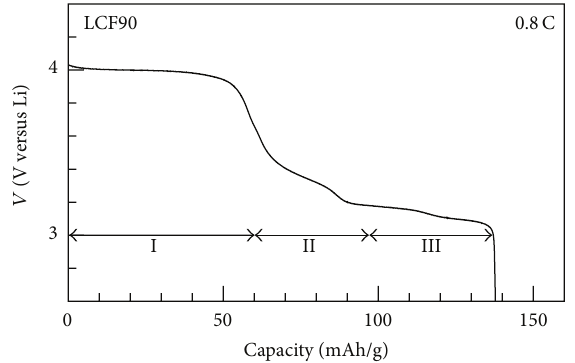
Figure 9: OCV discharge curves of LCF90 film against Li measured at 0.8 C. For convenience of explanation, we define plateaus I, II, and III (cited from [20]).